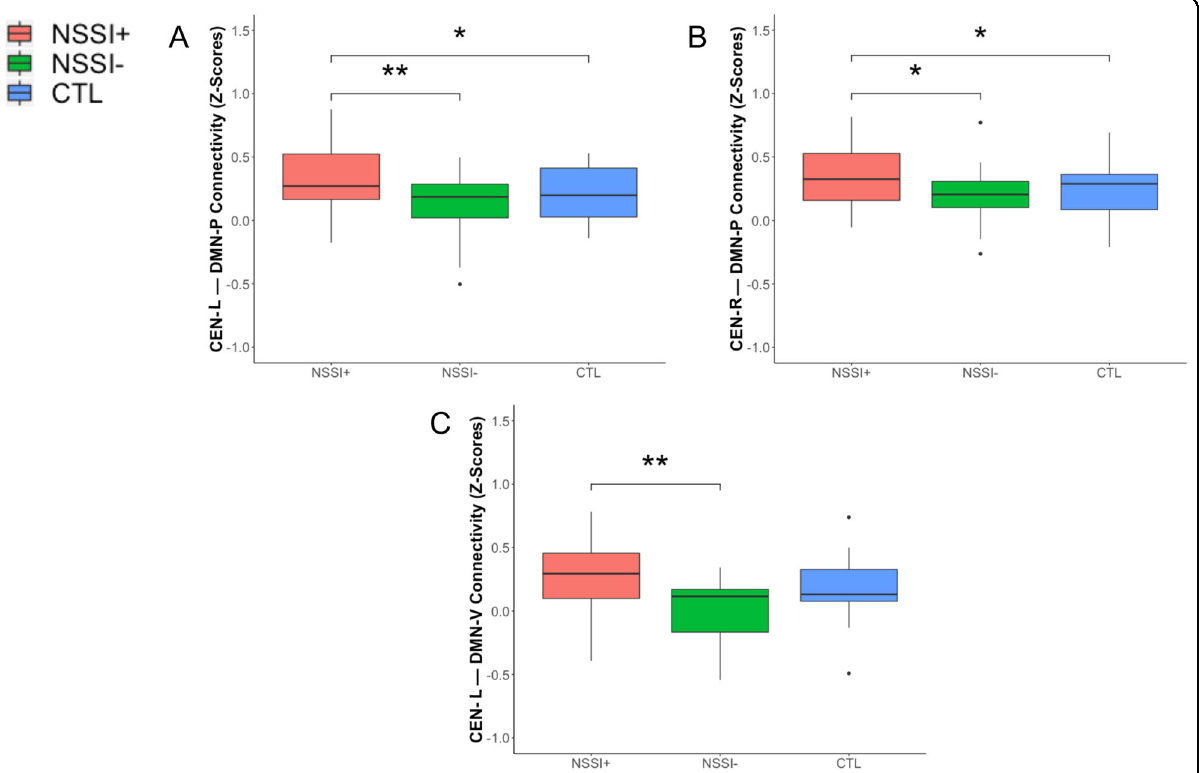
Fig. 4 Between network connectivity associated with non-suicidal self-injury. NSSI + exhibited signi fi cantly higher connectivity between the left ( a ) and right ( b ) CEN and DMN-P compared to NSSI − and CTL. NSSI + exhibited signi fi cantly higher connected between the left CEN and DMN-V ( c ) compared to NSSI − but not CTL. CEN central executive network, DMN-P posterior default mode network, DMN-V Ventral Default Mode Network, NSSI non-suicidal self-injury, CTL healthy controls. * p < 0.05, ** p < 0.01